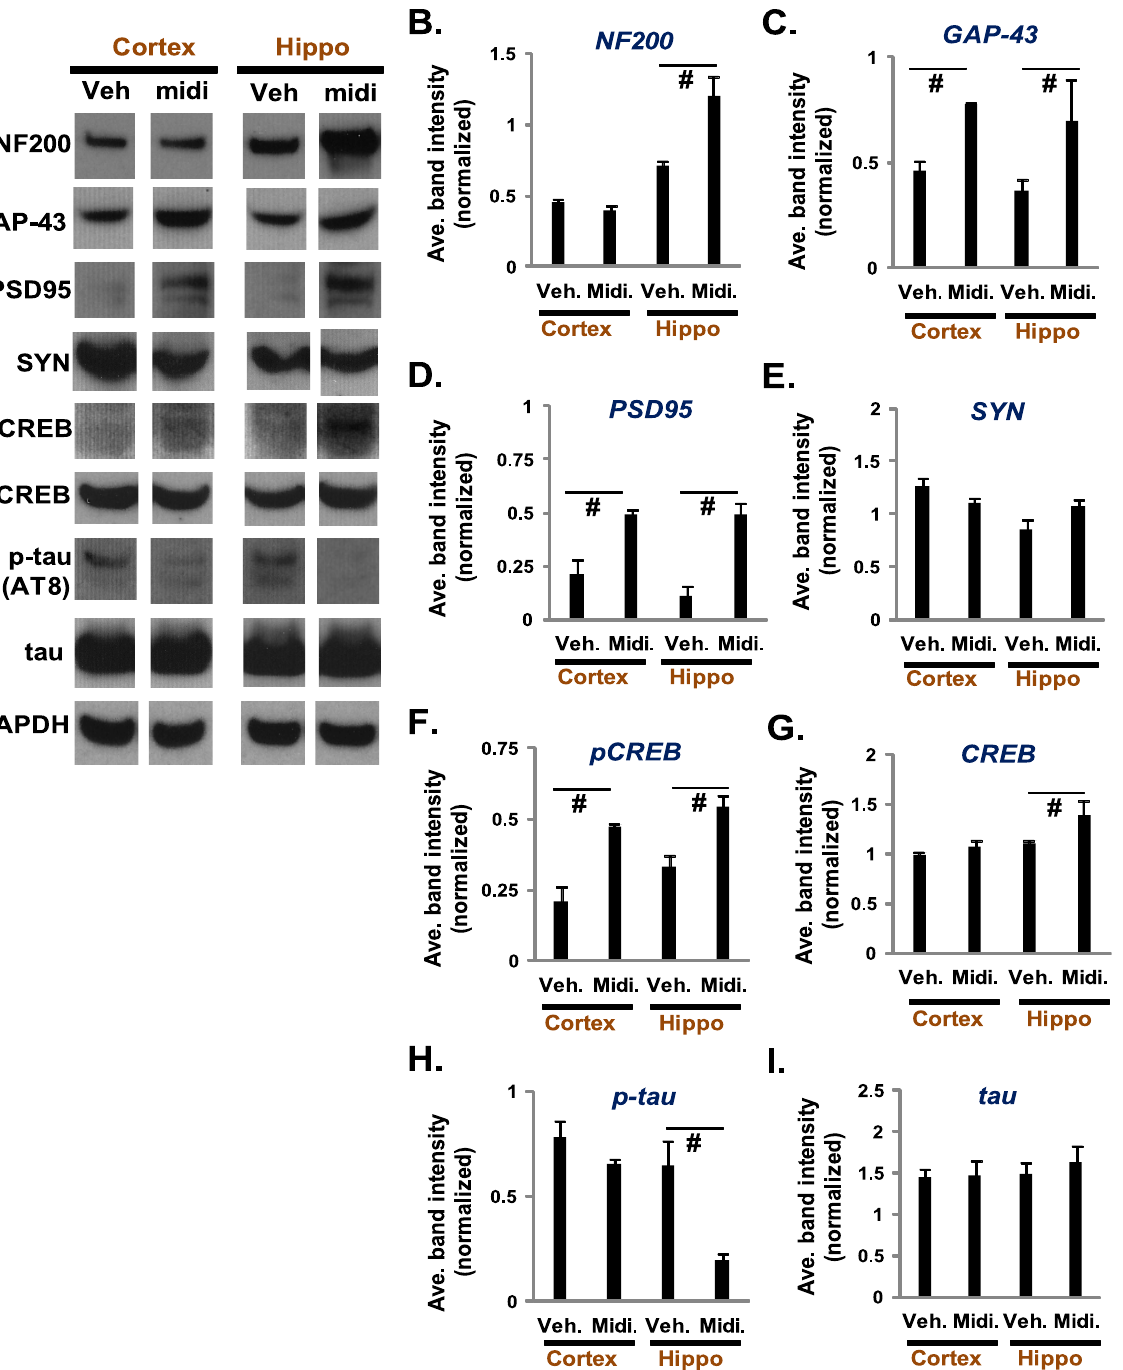
Fig 11. Intranasally administered midi-GAGR increased neuronal activity markers and decreased hyperphosphorylated tau in 3xTg-AD mice. (A) 12-week-old 3xTg-AD mice were intranasally administered with 40 μ L (20 μ L/nostril) of either sterile H 2 O (Veh.) or 1 mM midi-GAGR (midi) every day for 14 days and processed to obtain the cortex and hippocampus (Hippo). The tissues were homogenized to extract proteins for immunoblotting using the antibodies to NF200, GAP-43, PSD95, synaptophysin, pCREB, CREB, p-tau (AT8), tau, and GAPDH. (B-J) The densities of protein bands were measured using Image J and normalized to that of the loading control, GAPDH. Normalized values were used to calculate the average normalized band densities of NF200 (B), GAP-43 (C), PSD95 (D), synaptophysin (SYN, E), pCREB (F), total CREB (G), p-tau (H), and total tau (I). Data represent mean ± SEM of three independent animals. #, p < 0.01, * , p <